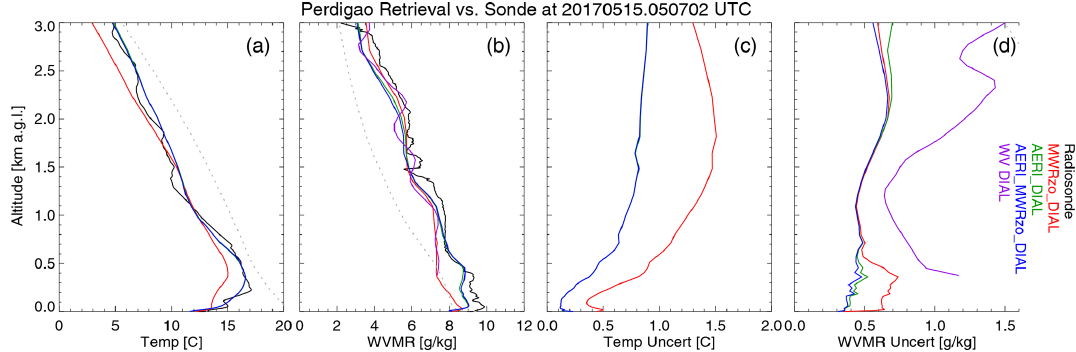
Figure 2. Same as Fig. 1, except that the retrievals combine active and passive data with the MWRzo + DIAL (red), AERI + DIAL (green), and AERI + MWRzo + DIAL (blue). The water vapor observed by the DIAL and its uncertainty are included in the retrievals. See text for more details.